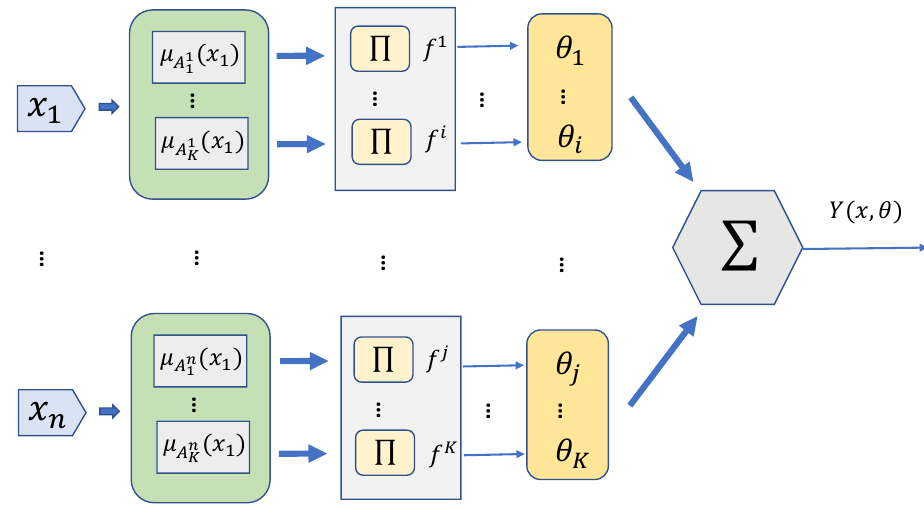
Figure 5. Structure of